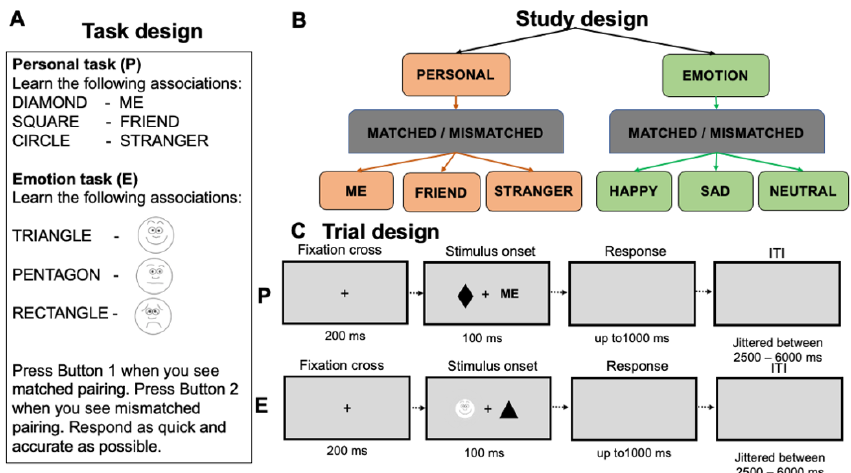
Figure 1. Experimental design ( A ), study design ( B ) and examples of stimuli in the personal and emotional tasks ( C ). emotional tasks ( C